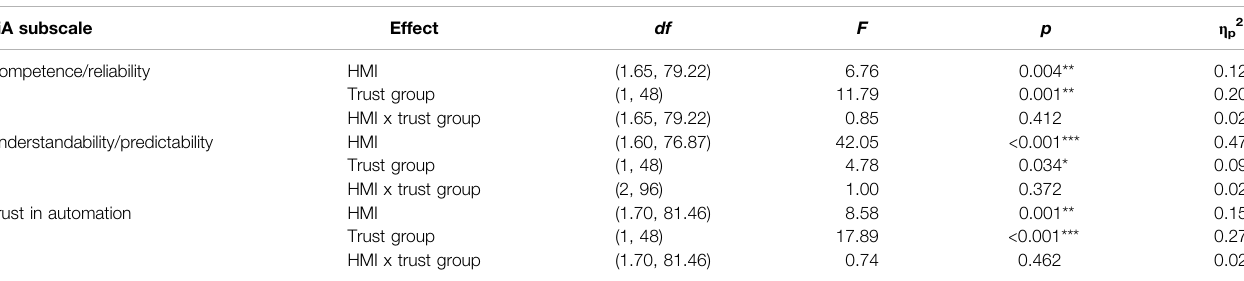
TABLE 4 | Mixed design ANOVA results on the effects of HMI condition and trust group membership on passengers ’ trust in automated vehicles. TiA